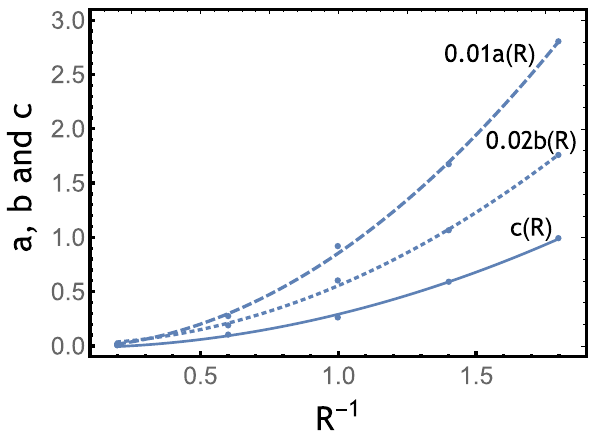
Fig. 2 Fitting coefficients a ( R ) , b ( R ) and c ( R ) with R −